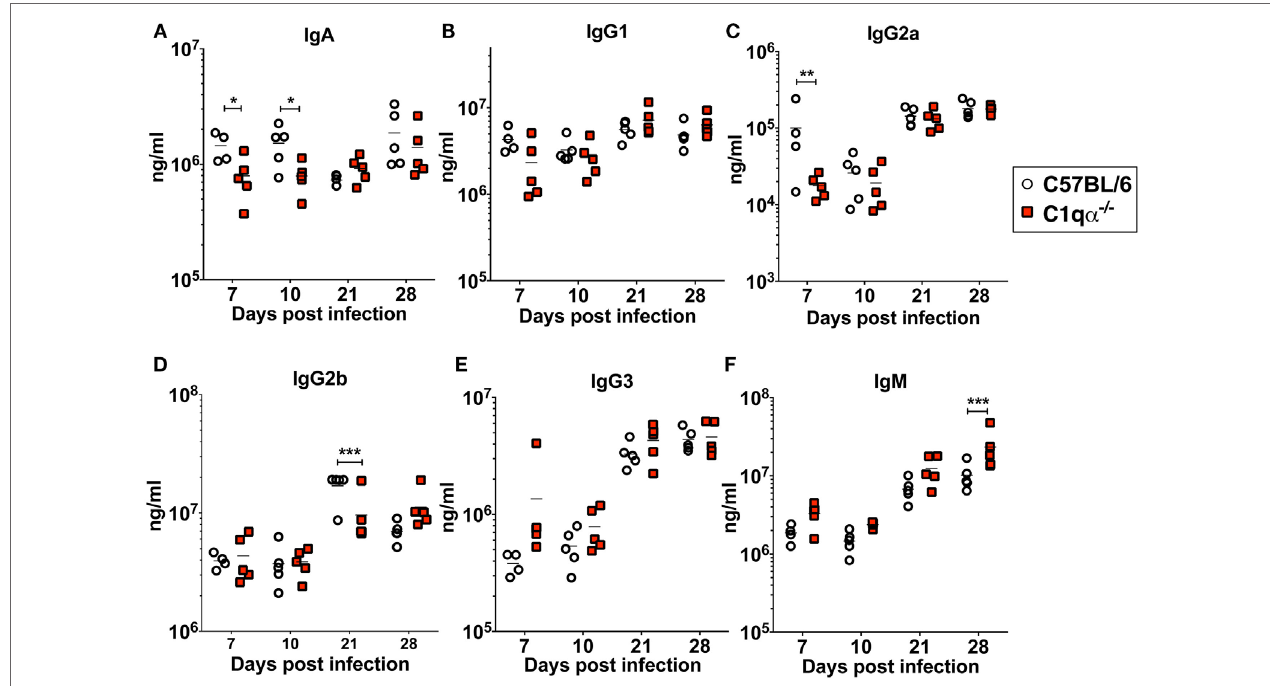
FigUre 5 | Lack of C1q affects the level of immunoglobulins IgA (a) , IgG1 (B) , IgG2a (c) , IgG2b (D) , IgG3 (e) , and IgM (F) in infected mice. Whole blood was collected from mice infected with 10 4 Borrelia burgdorferi strain MSK5 (24) at 7, 10, 21, and 28 days post-infection. Serum level of immunoglobulins was determined by the Bio-Plex system employing the Luminex multianalyte profiling technology. White circles refer to samples from C57BL/6 mice, whereas red squares represent data from C1q α − / − mice ( n = 5; * P < 0.05; ** P < 0.01; and *** P <